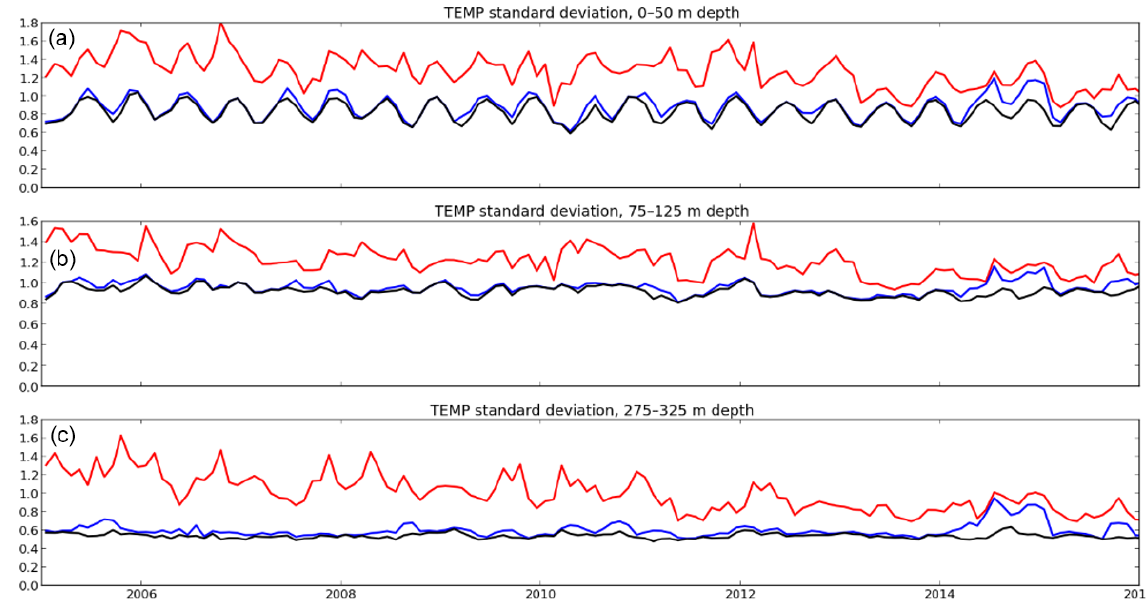
Figure 9. Mean temperature standard deviation in the 0–50m layer (a) , 75–125m depth layer (b) , and 275–325m depth layer (c) . The raw dataset (red), NRT dataset (blue), and CORA dataset (black) are